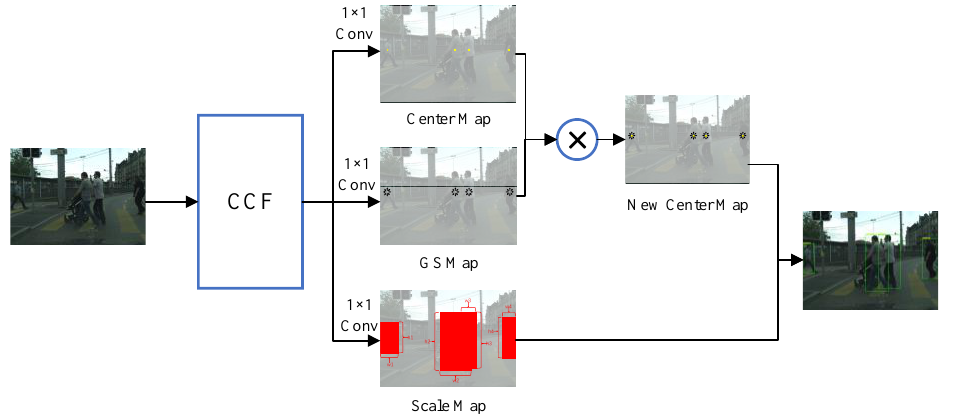
Figure 3. The overall architecture of the detection head mainly includes three map components, namely the center map, the scale map and the global smooth map